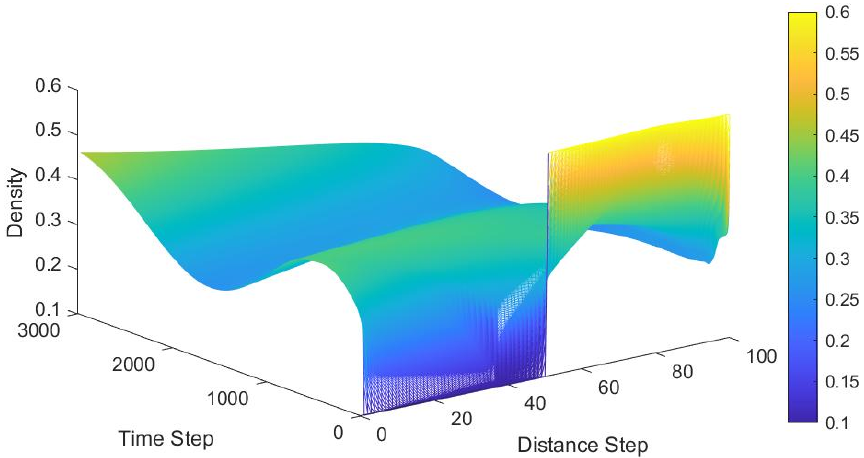
Figure 1. Density behavior of PW model on straight road with ingress traffic.